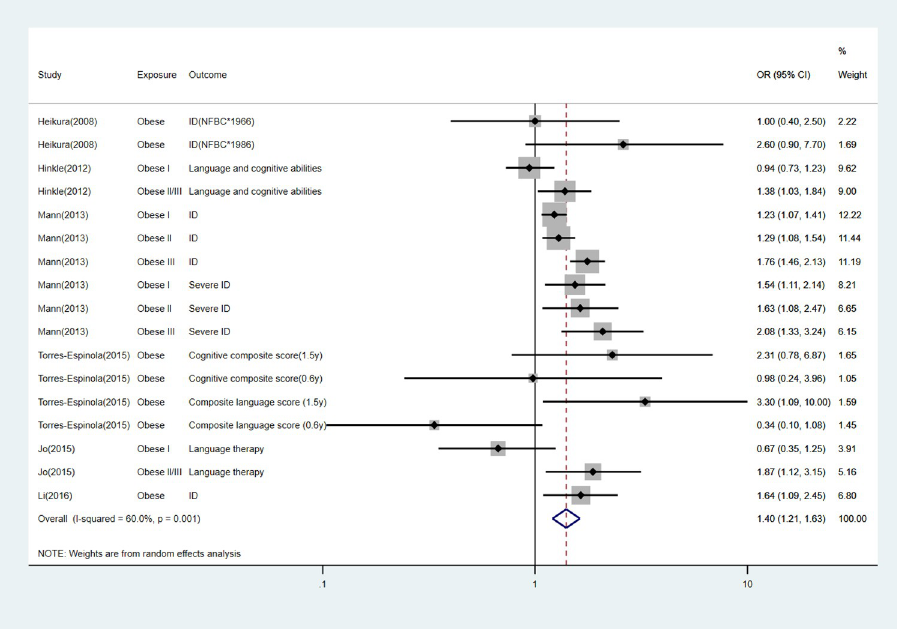
Fig 5. Forest plot for obese mothers and their offspring’s risk of cognitive/intellectual delay.